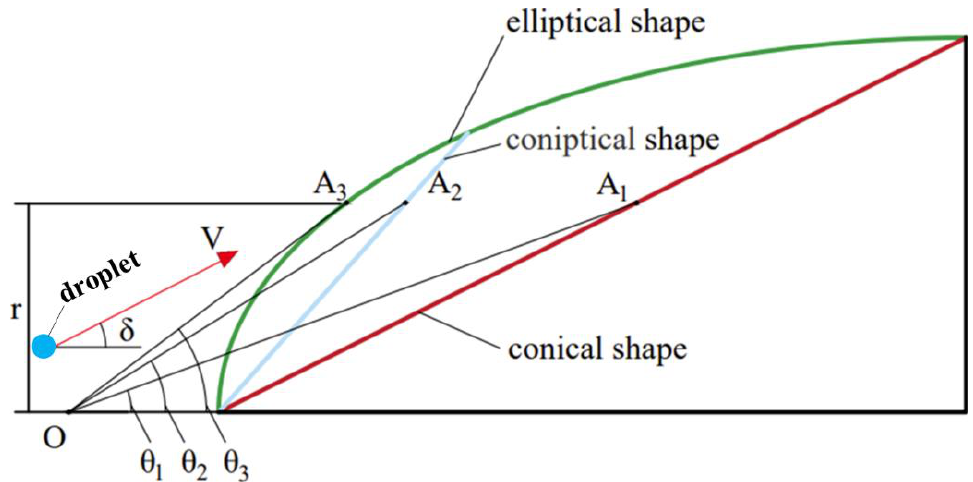
Figure 6. Main difference between the three types of cap structure.